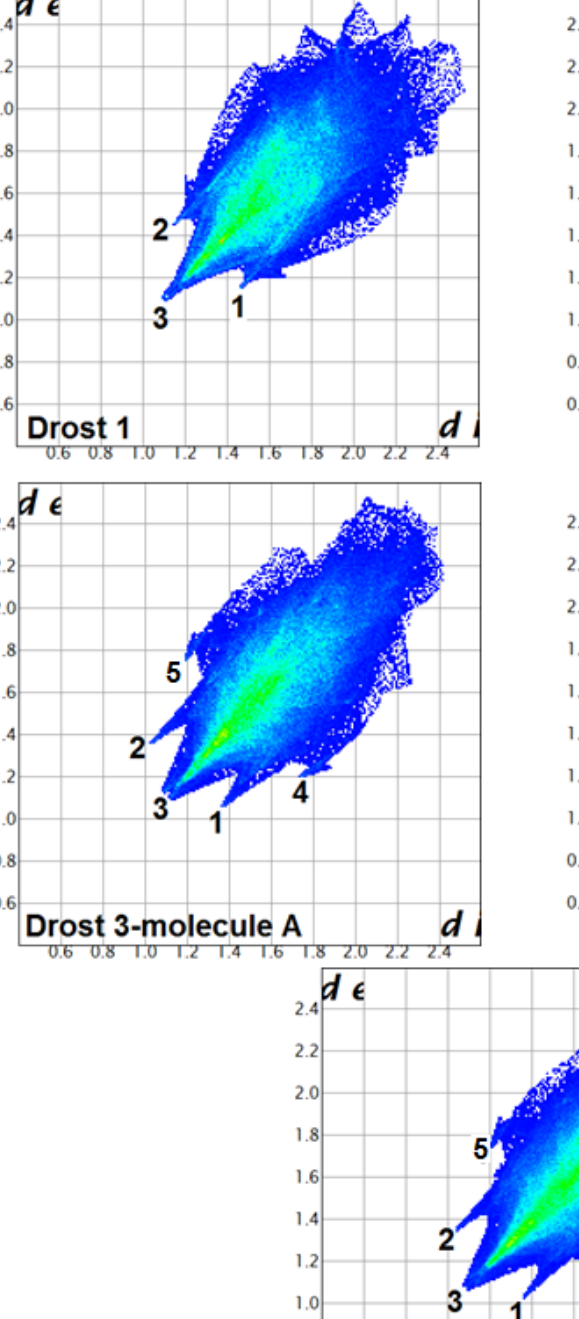
The percentage contributions to the Hirshfeld surfaces areas for studied crystals are represented in Table 4. The conclusions resulting from fingerprint plots analysis include the following. Molecules 2020 , 25 , x FOR PEER REVIEW